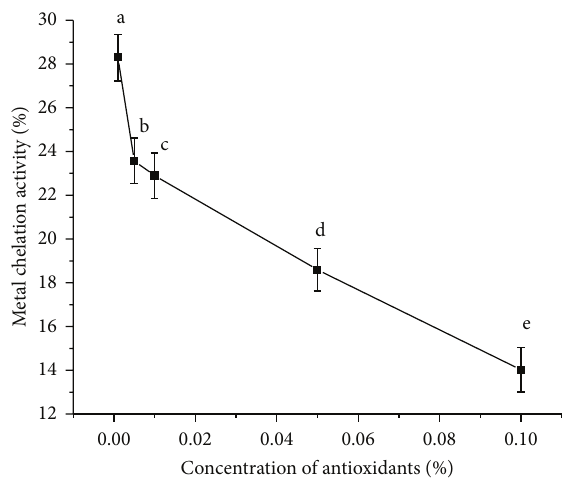
Figure 5: Metal chelation activity of 𝛼 - and 𝛽 -carotene crystals at different concentrations. Values are Mean ± SEM of 3 observations. At the 0.05 level, the difference in superscripts (a, b, c, d, e) indicates significant difference in means. Figure 6: ABTS-radical scavenging activity of